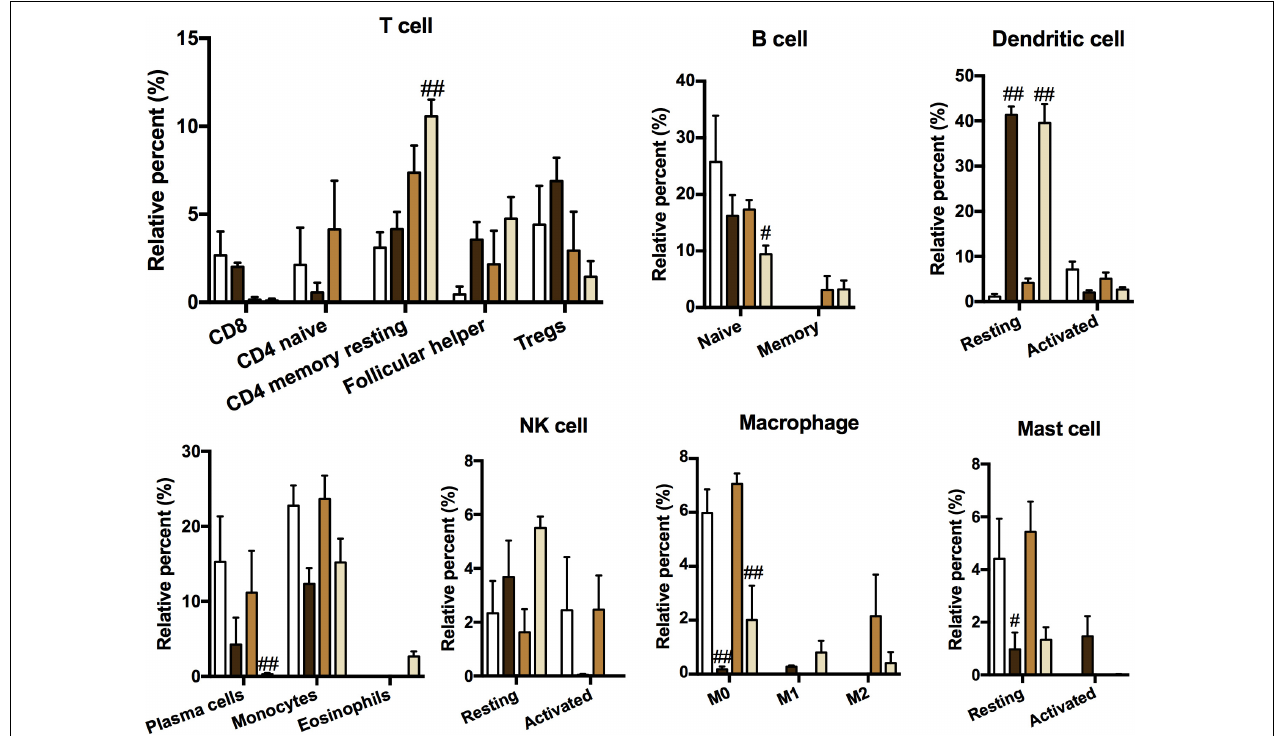
FIGURE 5 | Immune cell type and content analysis. The immune cell subtypes and relative expression levels were reconstructed according to the expression pattern of cell surface markers at the RNA level using CIBERSORT ( n = 3). Data were shown as mean ± SEM; # P < 0.05 and ## P < 0.01 compared with the control group.